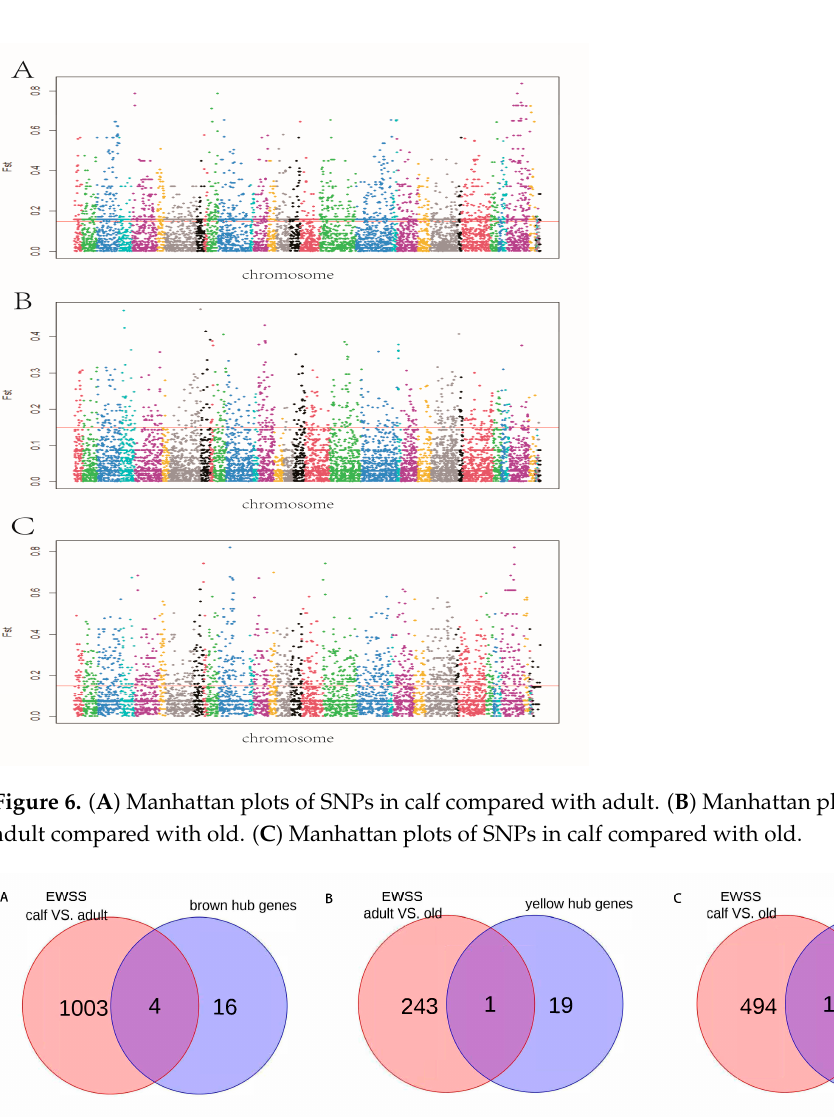
Figure 7. ( A ) Venn diagram of EWSS calf vs. adult and brown module hub genes. ( B ) Venn diagram of EWSS adult vs. old and yellow module hub genes. ( C ) Venn diagram of EWSS calf vs. old and blue module hub genes.